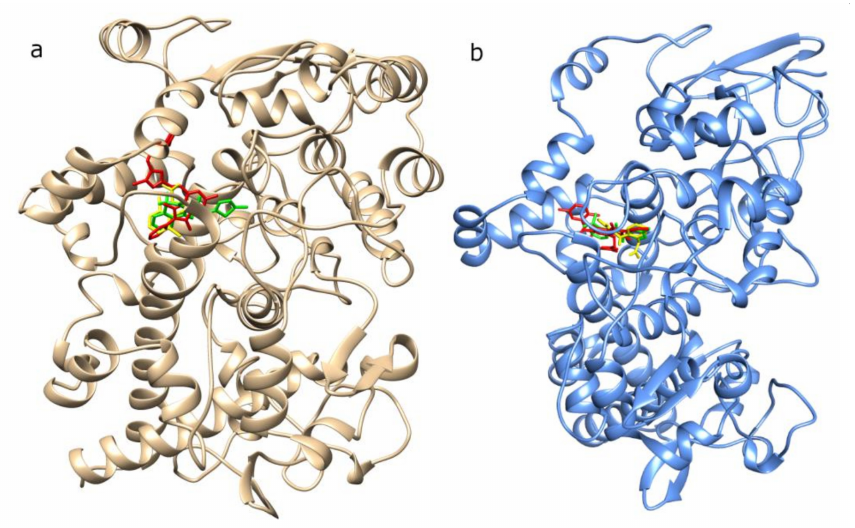
Figure 3. The binding mode of 2a (red), Meloxicam (green) and Diclofenac (yellow) in the active center of ( a ) COX-1 and ( b )